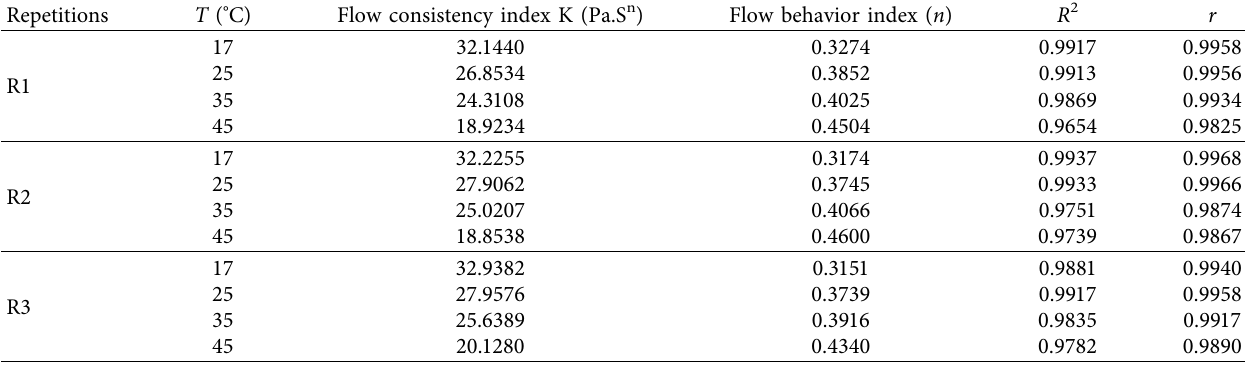
Table 5: Ostwald–De Waele model n and K parameters for loquat compote ( Mespilus germ´anica L.) with 0.20% agar from Chondracanthus chamissoi with three replicates: (A) repeat 1, (B) repeat 2, and (C) repeat 3 at four (17 ° C, 25 ° C, 35 ° C, and 45 ° C) temperatures.